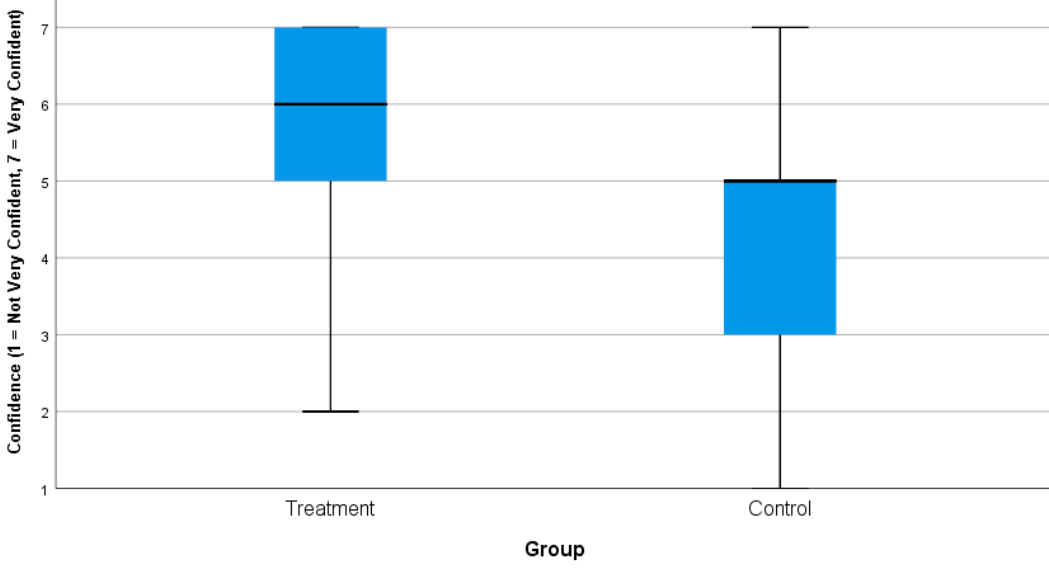
Figure 5. Box plot of confidence.